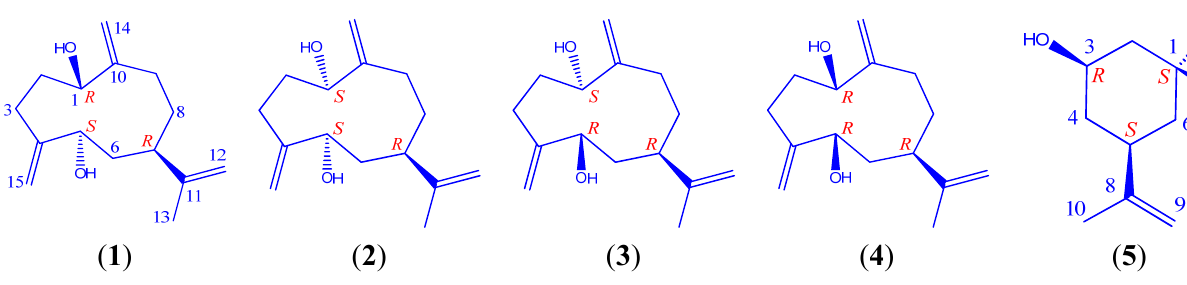
Figure 1. Structures of compounds 1 – 5